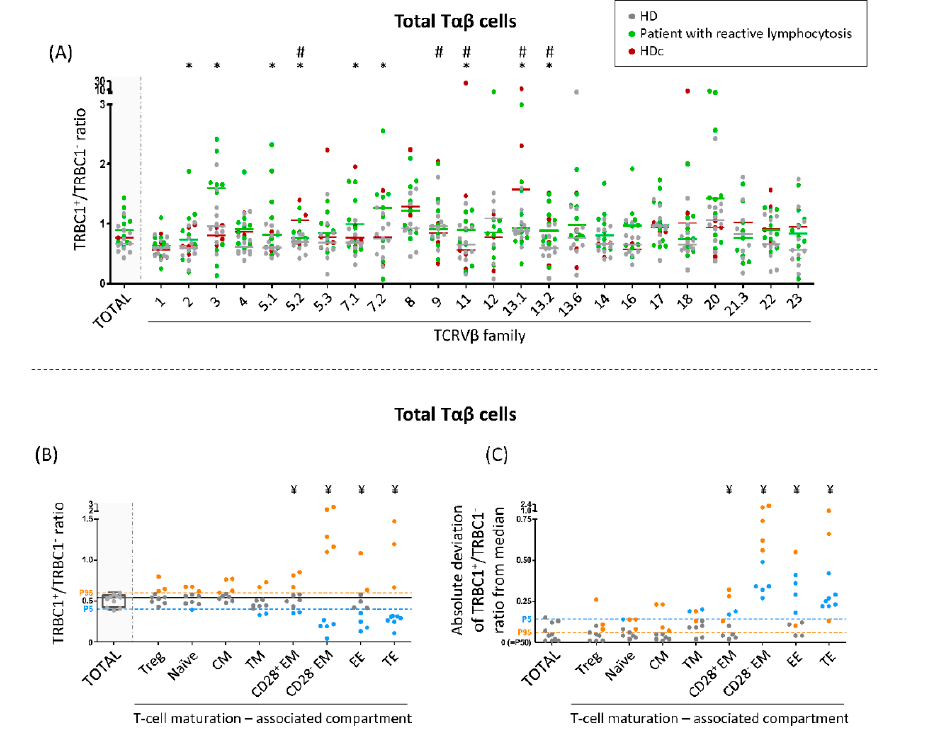
Figure 3. TRBC1 + /TRBC1 − ratio of normal total T αβ -cells according to the specific TCRV β family member expressed and their maturation stage. ( A ) TRBC1 + /TRBC1 − ratio of total T αβ -cells within each of the different TCRV β families identified by immunophenotype in 12 HD (gray dots), 10 patients with reactive lymphocytosis (green dots) and 5 otherwise healthy individuals showing a clonal expansion of Tab cells in blood (HDc, red plots). In these latter subjects, the TCRV β clonal population was removed from analysis. Colored horizontal lines are median values of the corresponding group of subjects ( p -value ≤ 0.05 for * reactive lymphocytosis vs. HD and for # HDc vs. HD) ( B , C ) TRBC1 + /TRBC1 − ratio observed among normal T αβ -cells from 10 HD, distributed into different maturation-associated compartments, represented both in individual ratio values per maturation stage ( B ) and their deviation from the median value (percentile 50 = 0; ( C )) ( ¥ ρ -value ≤ 0.05 vs. total T αβ -cells) In all panels, dots correspond to results from individual experiments while notched boxes represent 25th and 75th percentile values, lines inside the box correspond to median values (50th percentile) and whiskers represent minimum and maximum values. The continuous horizontal and dotted lines that cover the entire graph correspond to median values (percentile 50) and both the 5th and 95th percentiles (P5 and P95), respectively. Cases below P5 are depicted in blue, while cases above P95 are colored as orange dots. Abbreviations (alphabetical order): CM, central memory; DN, double negative (T αβ CD4 − CD8 − /lo ) T αβ -cells; DP, double positive (T αβ CD4 + CD8 + ) T αβ -cells; EE, early effector; EM, effector memory; HD, healthy donor; HDc, healthy donor with a small T αβ -cell clone in blood; TE, terminal effector; TM, transitional memory; Treg, regulatory